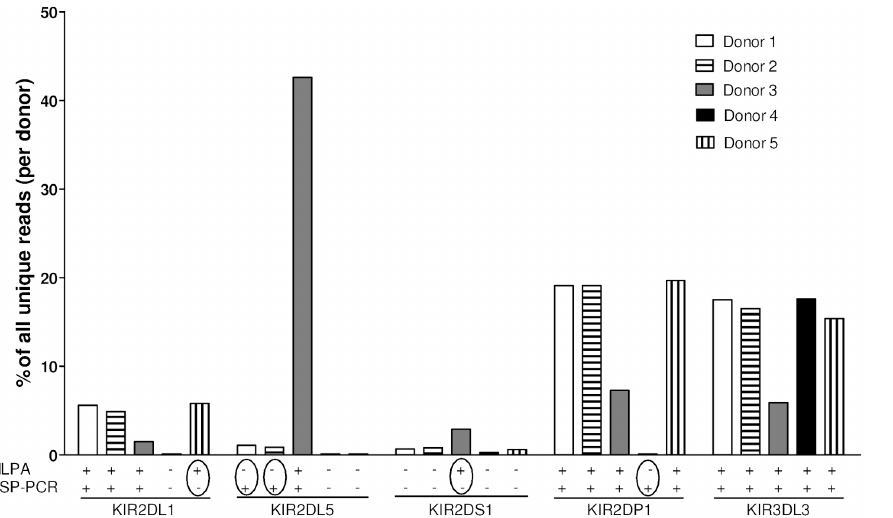
Figure 1. Validation of the accuracy of genotyping with MLPA by next-generation sequencing (NGS). Five of the genomes with mismatches between MLPA and PCR-SSP were analyzed by NGS. The percentage of reads that aligned against a reference for a KIR gene gives an impression about the presence of the KIR gene in that specific donor. Circles indicate the mismatches found between MLPA and PCR-SSP. KIR3DL3 is a control gene as it is present in all donors.